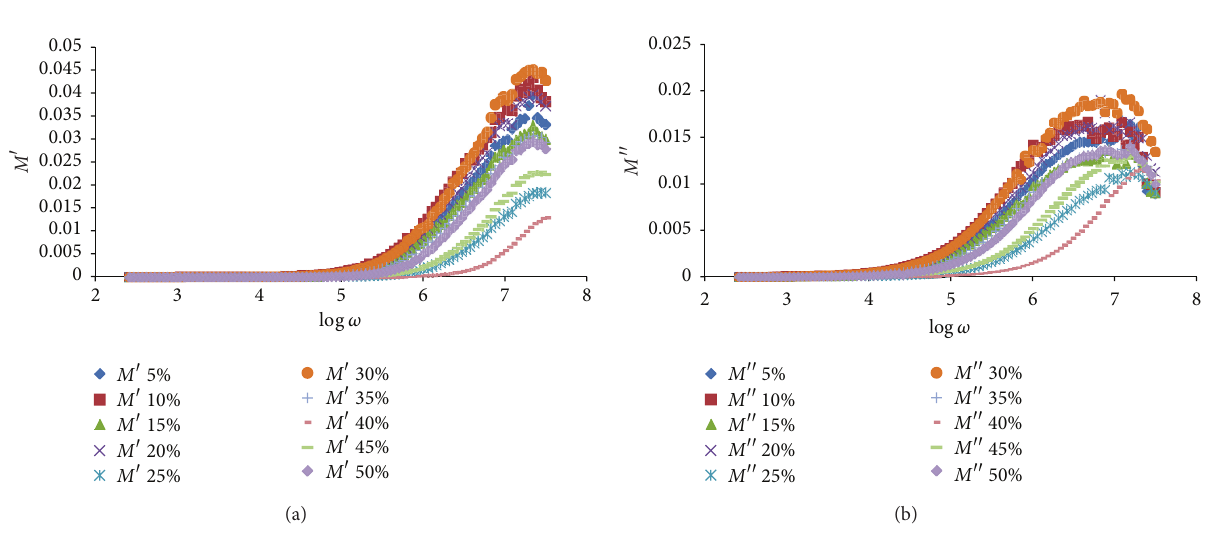
Figure 6: Variation of (a) real part (b) imaginary part of electric modulus variation with frequency for